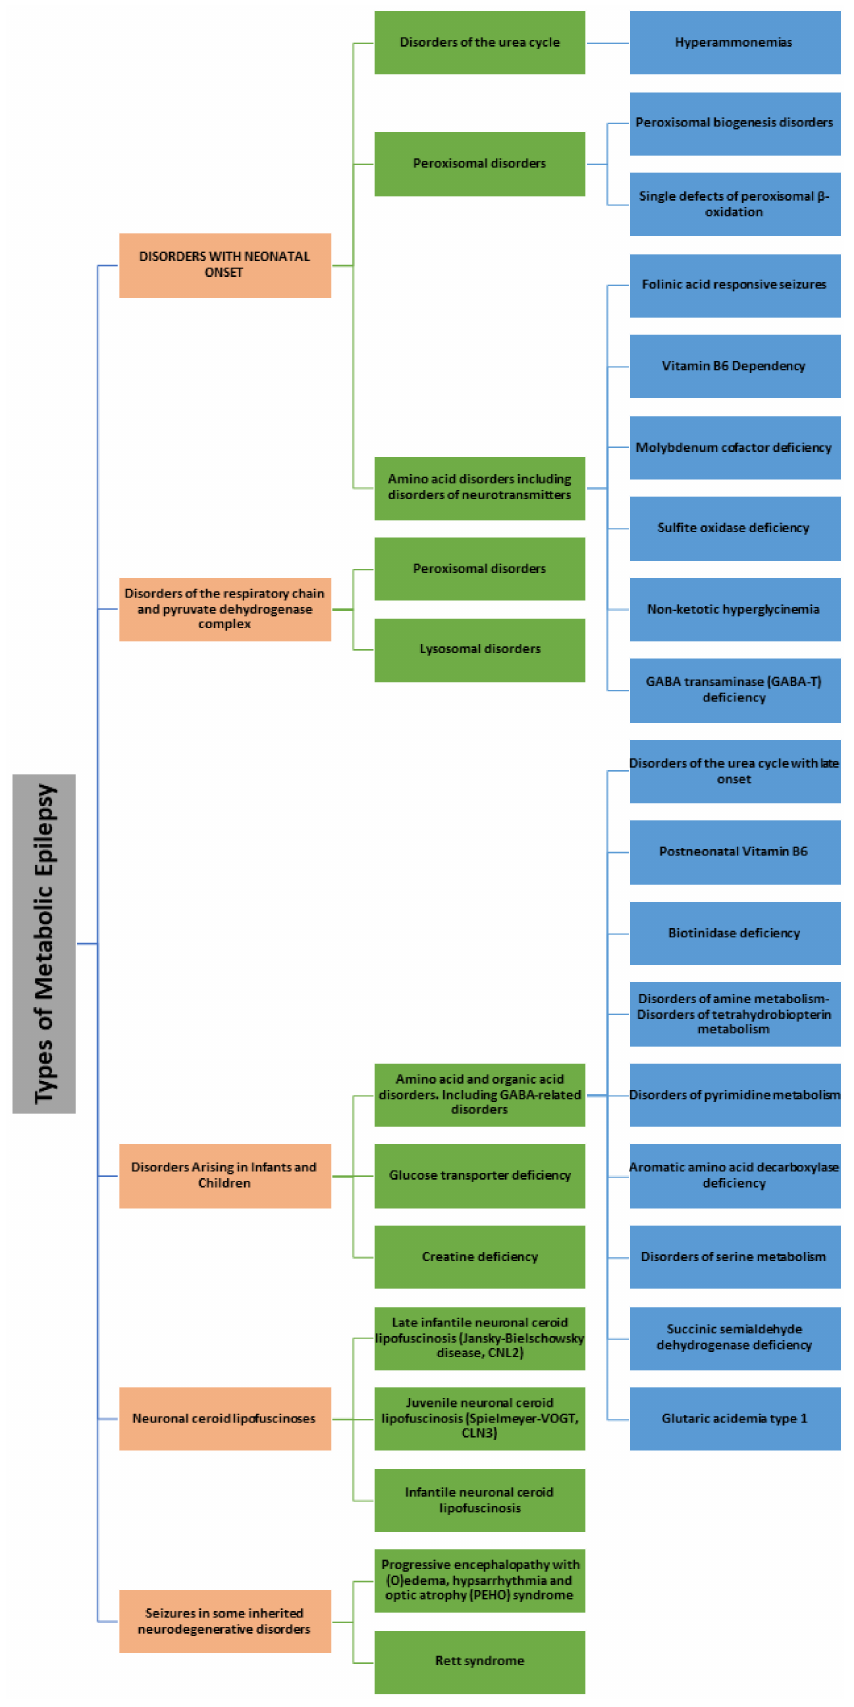
Figure 1. Types of Metabolic